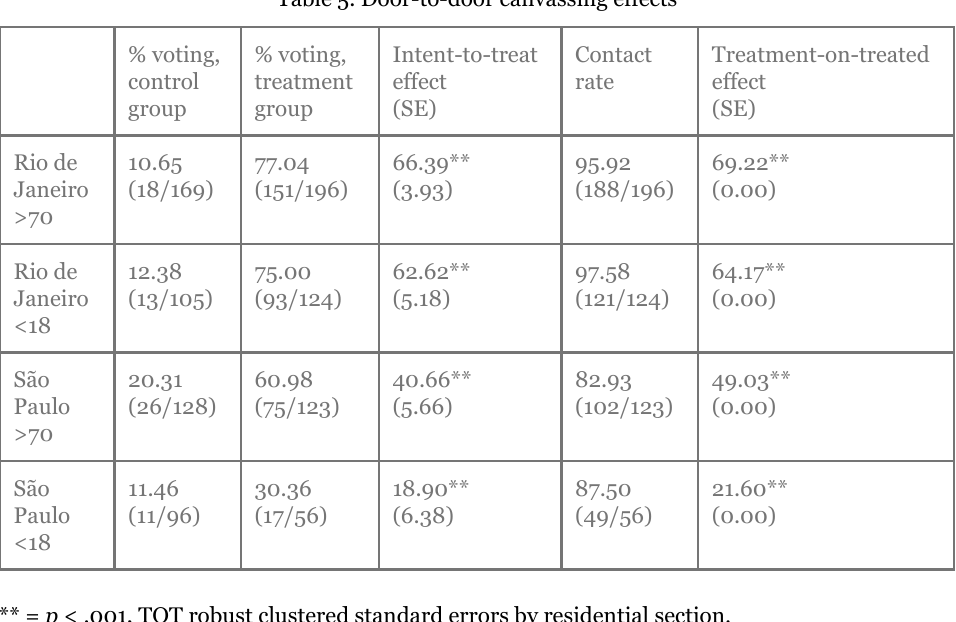
Table 5. Door-to-door canvassing effects